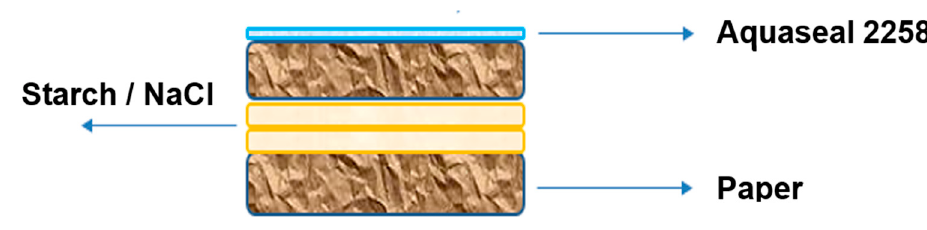
Figure 1 . Multilayer package (sandwich packaging). Figure 1. Multilayer package (sandwich